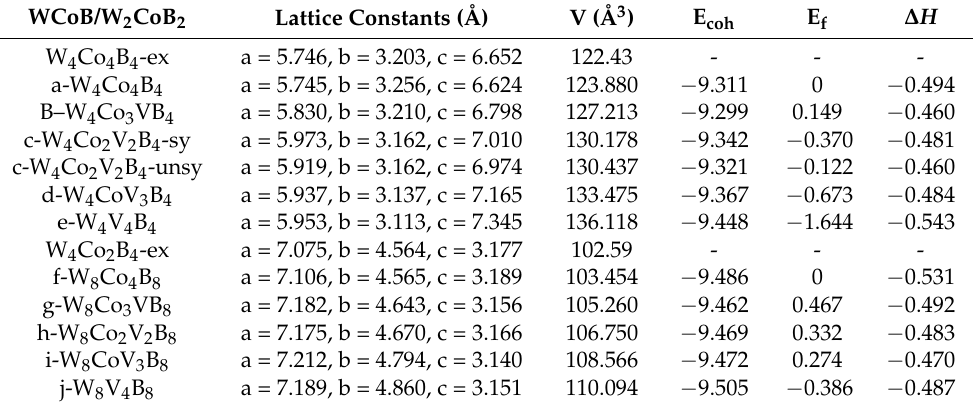
Table 1. Calculated results of lattice parameters, cohesive energy E coh (eV/atom), impurity